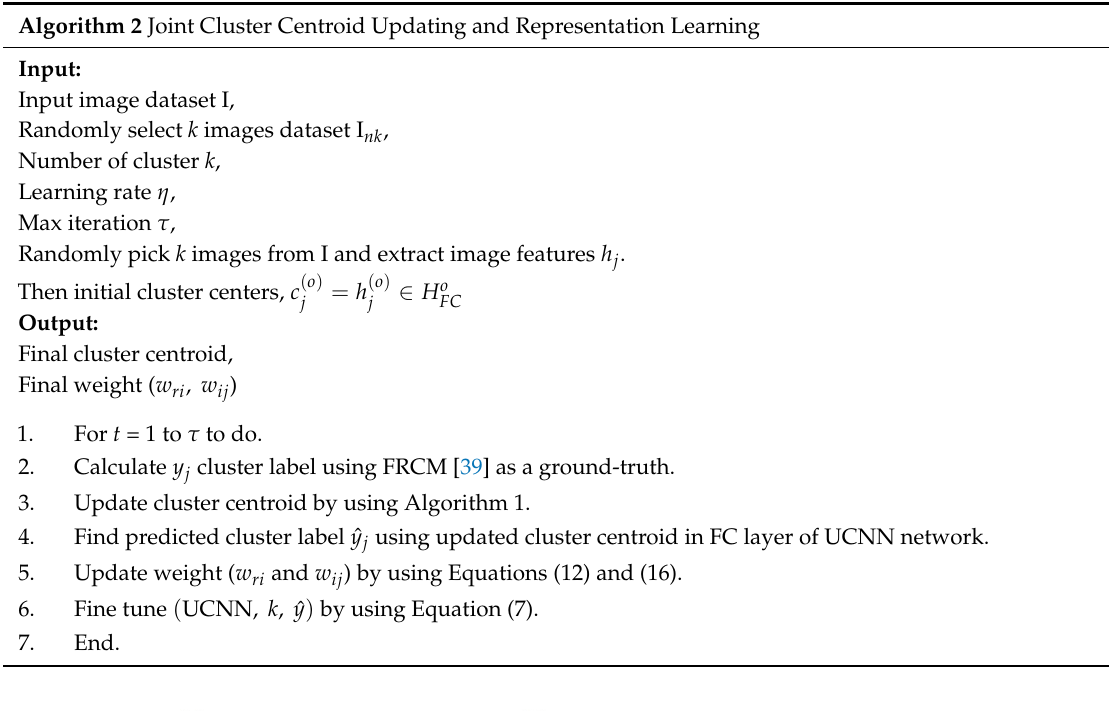
Algorithm 2 Joint Cluster Centroid Updating and Representation Learning